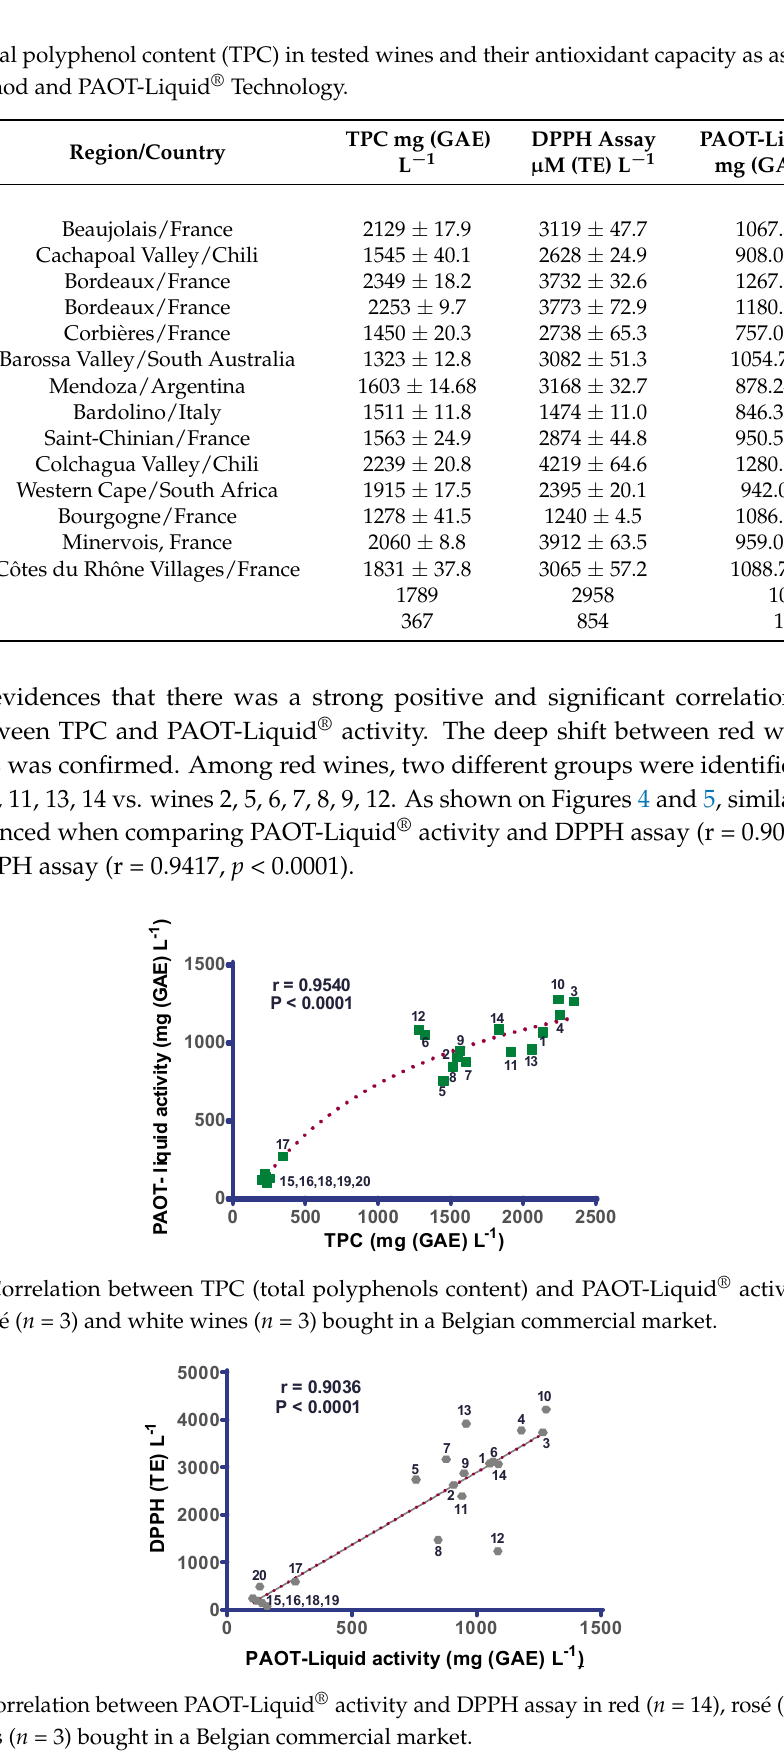
Figure 5. Correlation between TPC (total polyphenols content) and antioxidant capacity as assessed by DPPH assay in red ( n = 14), rosé ( n = 3) and white wines ( n = 3) bought in a Belgian commercial market. 5. Conclusions In conclusion, we have developed the PAOT-Liquid ® Technology that turns out to be a direct and useful tool for evaluating antioxidant capacity of red, rosé and white wines. When compared to classical DPPH or ORAC assays which require long and fastidious protocols [24], the determination of antioxidant capacity of wines evaluated by the PAOT-Liquid ® Technology was achieved within 10 min and without requiring analytical systems such as spectrophotometers or plaque readers, rendering the method easily accessible to the winemaker himself. One of the great weakness of classical DPPH or ORAC assays for measuring antioxidant capacity is also the absence of standardized protocols. In the literature, there are substantial differences in sample preparation, selection of end-points and expression of results [24], so that comparison between the values reported by different laboratories is quite difficult [25]. Thanks to its simple and automatized protocol, PAOT- Liquid ® Technology overcomes these problems being operator independent. Due to the strong correlation between antioxidant activity determined by the PAOT-Liquid ® Technology and TPC and using a calibration curve, winemakers could, therefore, be able to quickly monitor themselves if modifications in TPC content occur or not from grape harvest until wine bottling and storage. At least, another advantage of the PAOT-Liquid ® Technology is its moderate cost (around 10 €) when compared to more expensive tests performed in specialized laboratory analysis. Of interest is to note that the PAOT-Liquid ® Technology can also be used for determining antioxidant capacity of other types of non-alcoholic beverages, such as orange juices or plant extracts, as already described by us [26]. Author Contributions: P.J. was the initiator of the study and has contributed to the paper draft with the help of E.E.R. K.C. and T.J. determined the total polyphenol content (TPC) in tested wines as well as their antioxidant